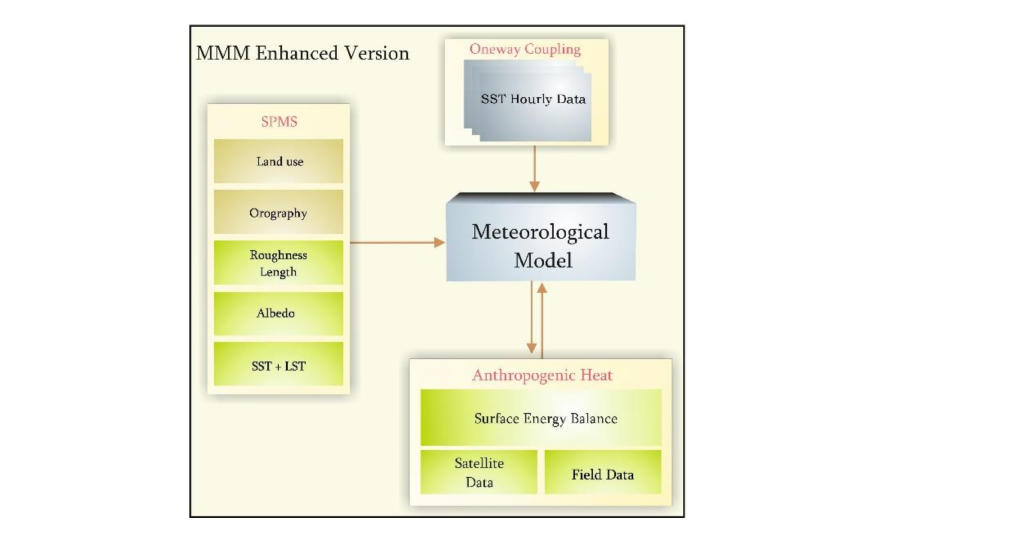
Figure 1. Schematic representation of the proposed Mesoscale Meteorological Model Enhanced Version.